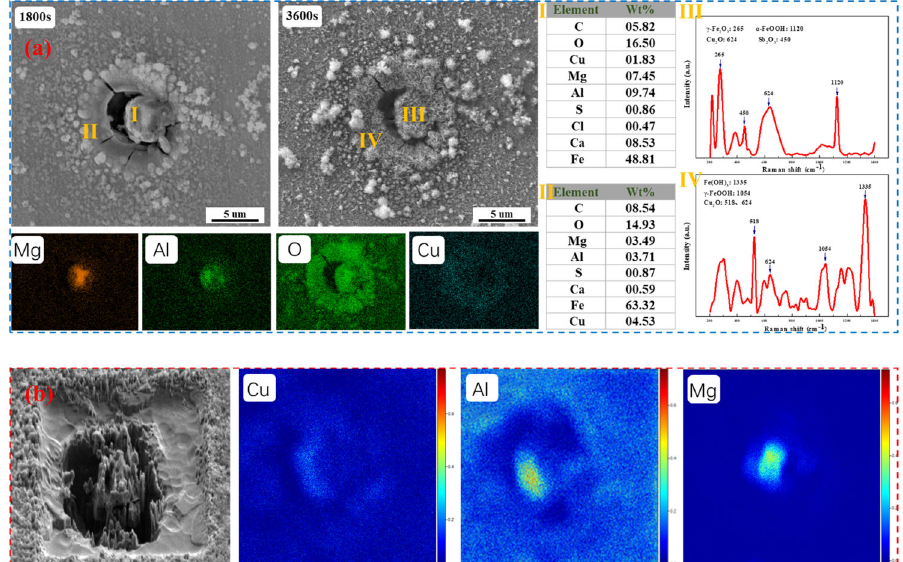
Fig. 13 Corrosion morphology and product analysis of Cu-containing inclusion with 0.1 mol/L NaCl immersion. a EDS and micro-Raman analysis of the inclusion after different times of immersion. b TOF-SIMS analysis of the CaS/CaO – MgO – Al 2 O 3 inclusion after 3600 s immersion. Published in partnership with CSCP and USTB npj Materials Degradation (2023)